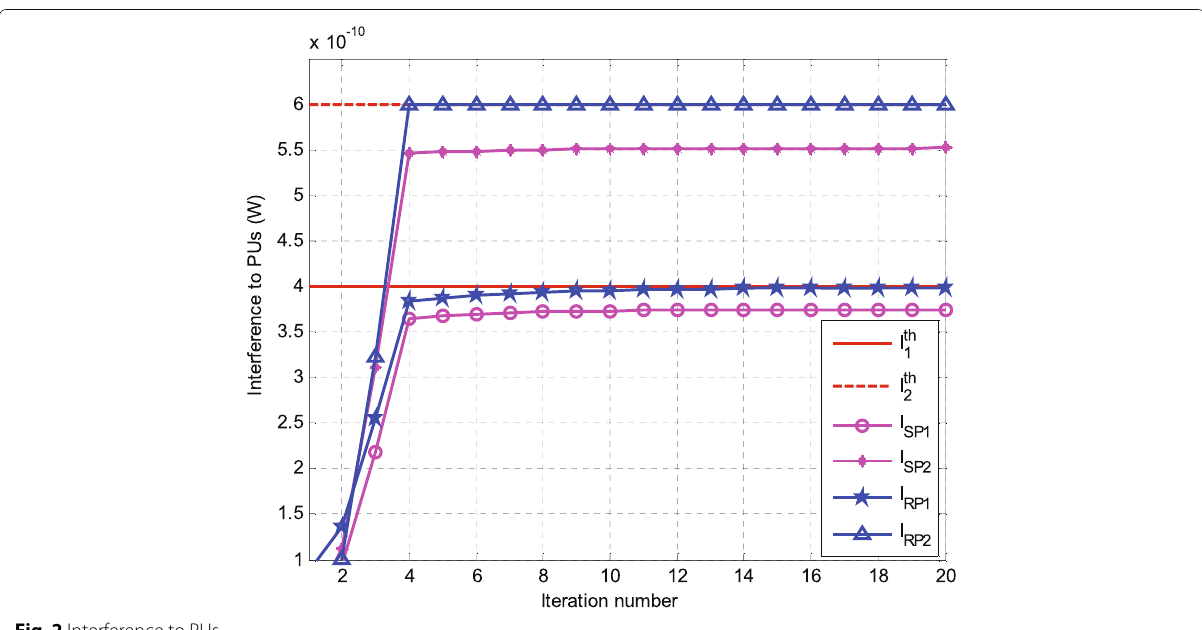
Fig. 2 Interference to PUs